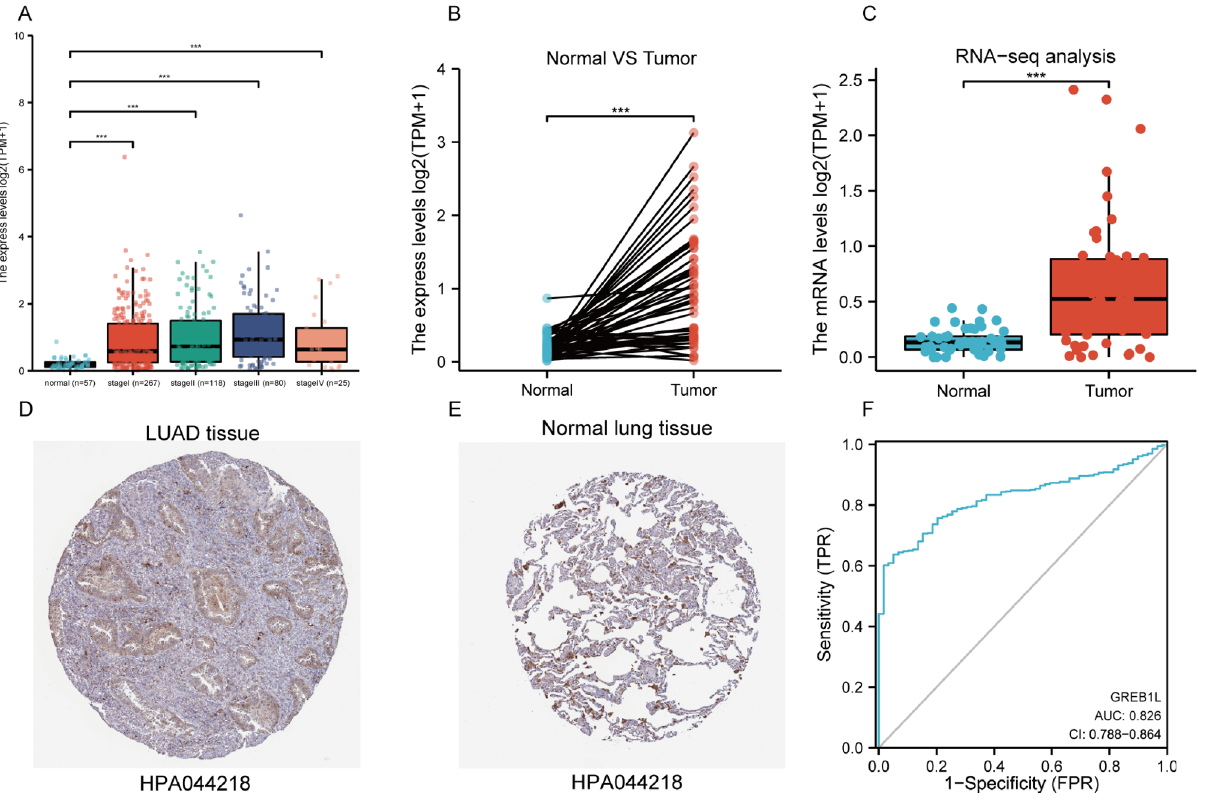
Figure 1. GREB1L expression levels in LUAD from TCGA data. ( A ) Expression levels of GREB1L in LUAD and normal tissue; ( B ) the expression of GREB1L in LUAD and its paired adjacent tissues; ( C ) the mRNA expression of GREB1L in LUAD was obtained from the GSE140343; ( D , E ) the protein expression of GREB1L in LUAD was obtained from the Human Protein Atlas; ( F ) receiver operating characteristic analysis (ROC) of GREB1L in LUAD (*p < 0.05, **p < 0.01, ***p <